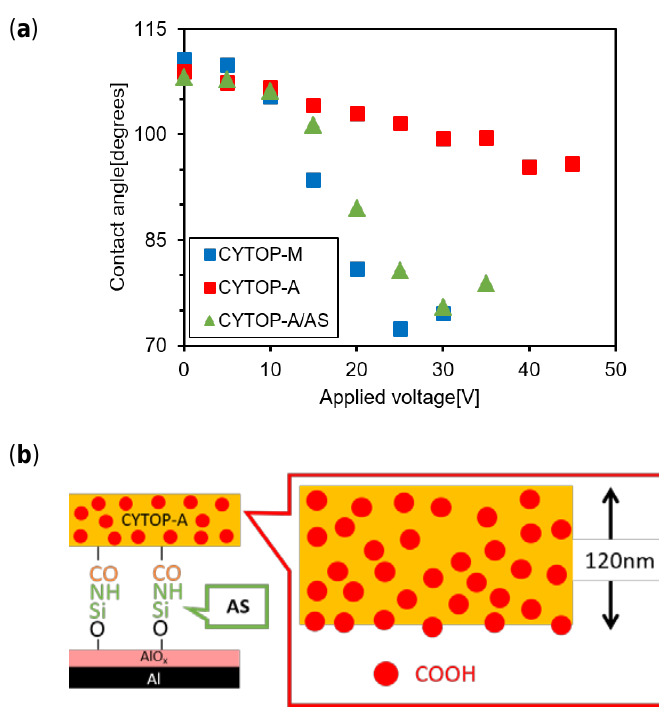
Figure 5. ( a ) EWOD curve of CYTOP-M (blue), CYTOP-M (red), and CYTOP-A / AS (green). All samples were placed on AlO x / Al. ( b ) Stacked CYTOP-A / AS / AlO x / Al device structure model. The interface of CYTOP-A / AlO x was covalently bonded by adding AS between CYTOP-A and AlO x , and the high polar groups (amino silane) were placed at the interface.